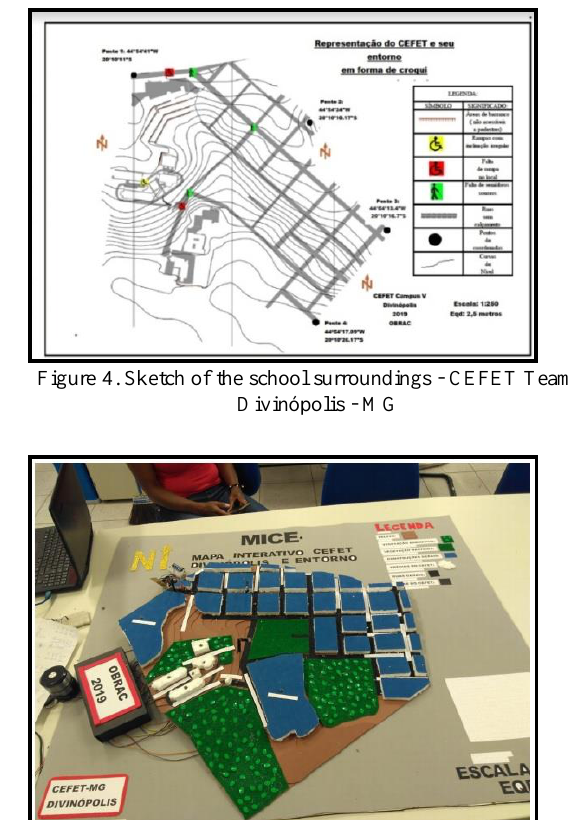
Figure 5. Tactile map with sound resource - CEFET team from Divinópolis – MG